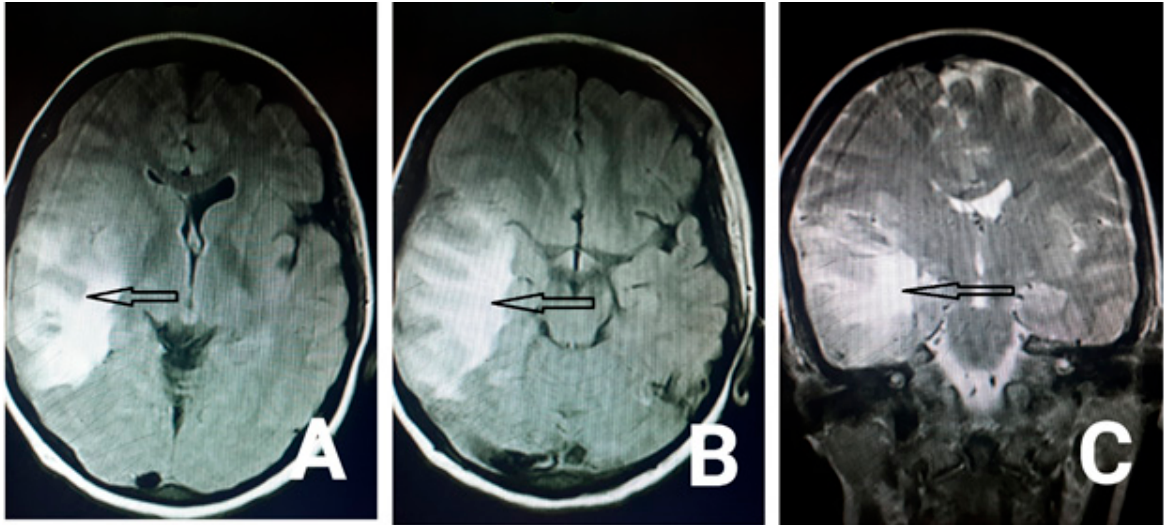
Figure 2. Axial fluid-attenuated inversion (flair) MRI (the arrows in the Figure ( A ) and ( B )) and coronal T2 weighted image (the arrow in the Figure ( C )) show hyperintensity in the right temporal lobe in the drainage territory of the vein of Labbe.